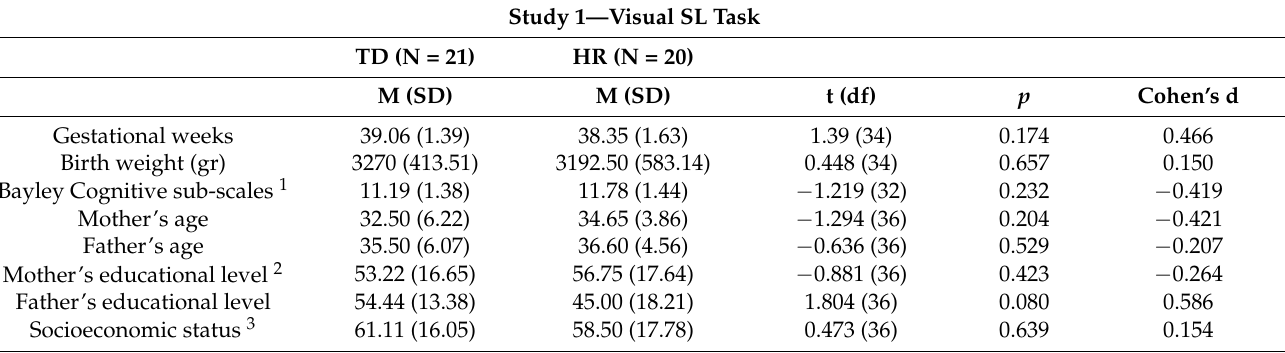
Table 1. Descriptive statistics (mean and standard deviations) of demographic characteristics for the TD and the HR